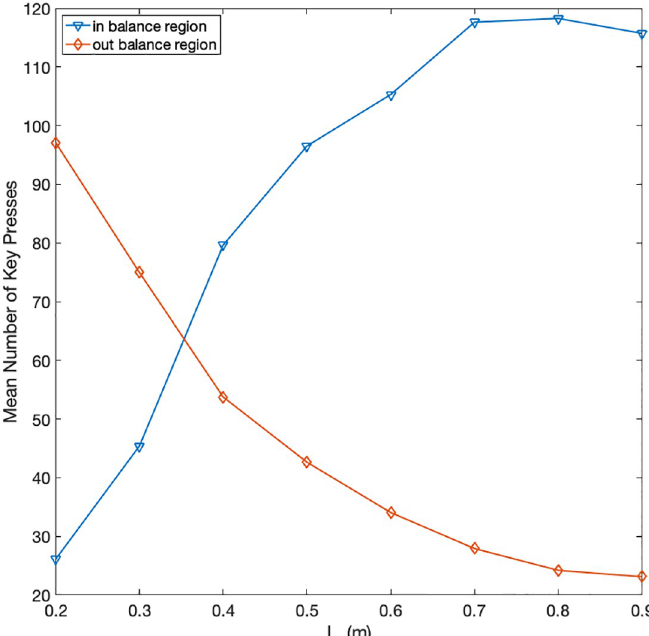
Fig 9. Key press activity within and outside balance region ( ± 0.27 rad from the vertical axis) for each pendulum length L